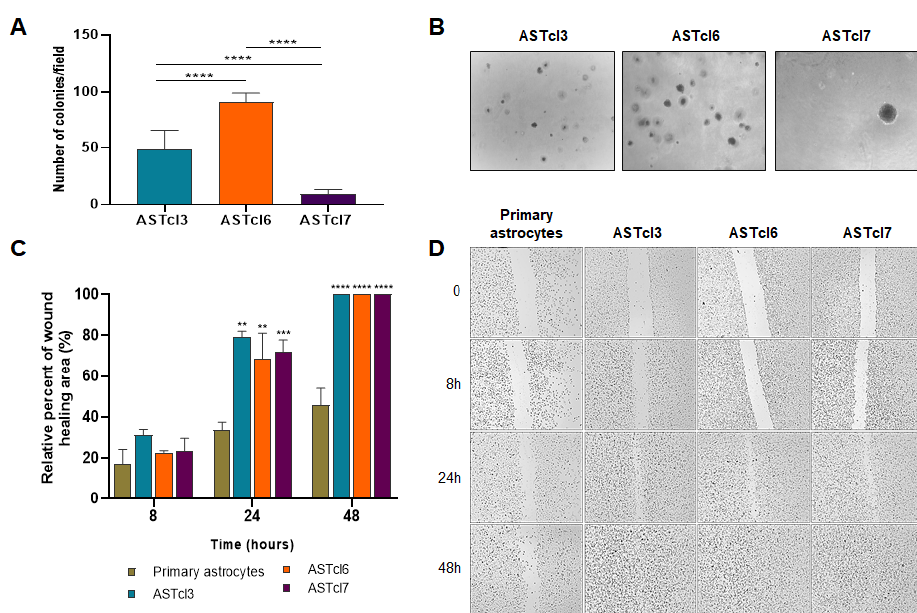
Figure 4. ASTcl3, ASTcl6, and ASTcl7 cells were able to grow independently of anchorage and mi ‐ grate collectively. The capability of astrocyte ‐ derived clones (ASTcl3, ASTcl6, and ASTcl7) to form colonies in soft agar is shown in ( A ) (number of colonies) and ( B ) (colonies’ size; magnification of 4×). The bars represent the average number of colonies per well ± standard deviation of two inde ‐ pendent experiments, in triplicate. ( C ) Graph representing the area occupied after migration by ASTcl3, ASTcl6, and ASTcl7 cells compared to primary astrocytes at 0, 8, 24, and 48 h after scratch ‐ ing. ( D ) Representative photomicrographs (10× magnification) of wound healing of primary astro ‐ cytes and ASTcl3, ASTcl6, and ASTcl7 cells at 0, 8, 24, and 48 h. The results are expressed as the means ± standard deviations (triplicate) of two independent experiments. Asterisks indicate statis ‐ tically significant differences between ASTcl3, ASTcl6, and ASTcl7 in relation to primary astrocytes at different times: ** p < 0.001, *** p < 0.0001, and **** p < 0.00001. Given that TMZ is the drug prescribed as the GBM standard of care, the response of astrocyte ‐ derived clones to TMZ was evaluated by 3 ‐ (4,5 ‐ dimethyl ‐ 2 ‐ thiazolyl) ‐ 2,5 ‐ di ‐ phenyl ‐ 2H ‐ tetrazolium bromide (MTT) and colony ‐ formation assays. First, the 50% inhib ‐ itory concentration (IC50) of TMZ was determined for the ASTcl3, ASTcl6, and ASTcl7 clones, yielding values of 0.7223 mM, 0.7189 mM, and 0.7175 mM, respectively (Figure S2). Cell proliferation assays of the three clones were then performed with 0.72 mM TMZ for 24, 48, and 72 h (Figure 5A). A decrease in cell viability was observed for all three clones after 48 and 72 h of TMZ treatment. However, the difference was only significant for ASTcl7 relative to the respective untreated control ( p < 0.0001 at 48 h, p < 0.001 at 72 h) (Figure 5A). Notably, the response of ASCTcl7 to TMZ was very similar to the response of U87MG—an established tumor cell line derived from human GBM. Additionally, the clonogenic capacity of the three clones was significantly decreased after treatment with 0.72 mM TMZ ( p < 0.001 for ASTcl3, and p < 0.0001 for both ASTcl6 and ASTcl7). However, a total halt in colony formation was not achieved (Figure 5B,C).